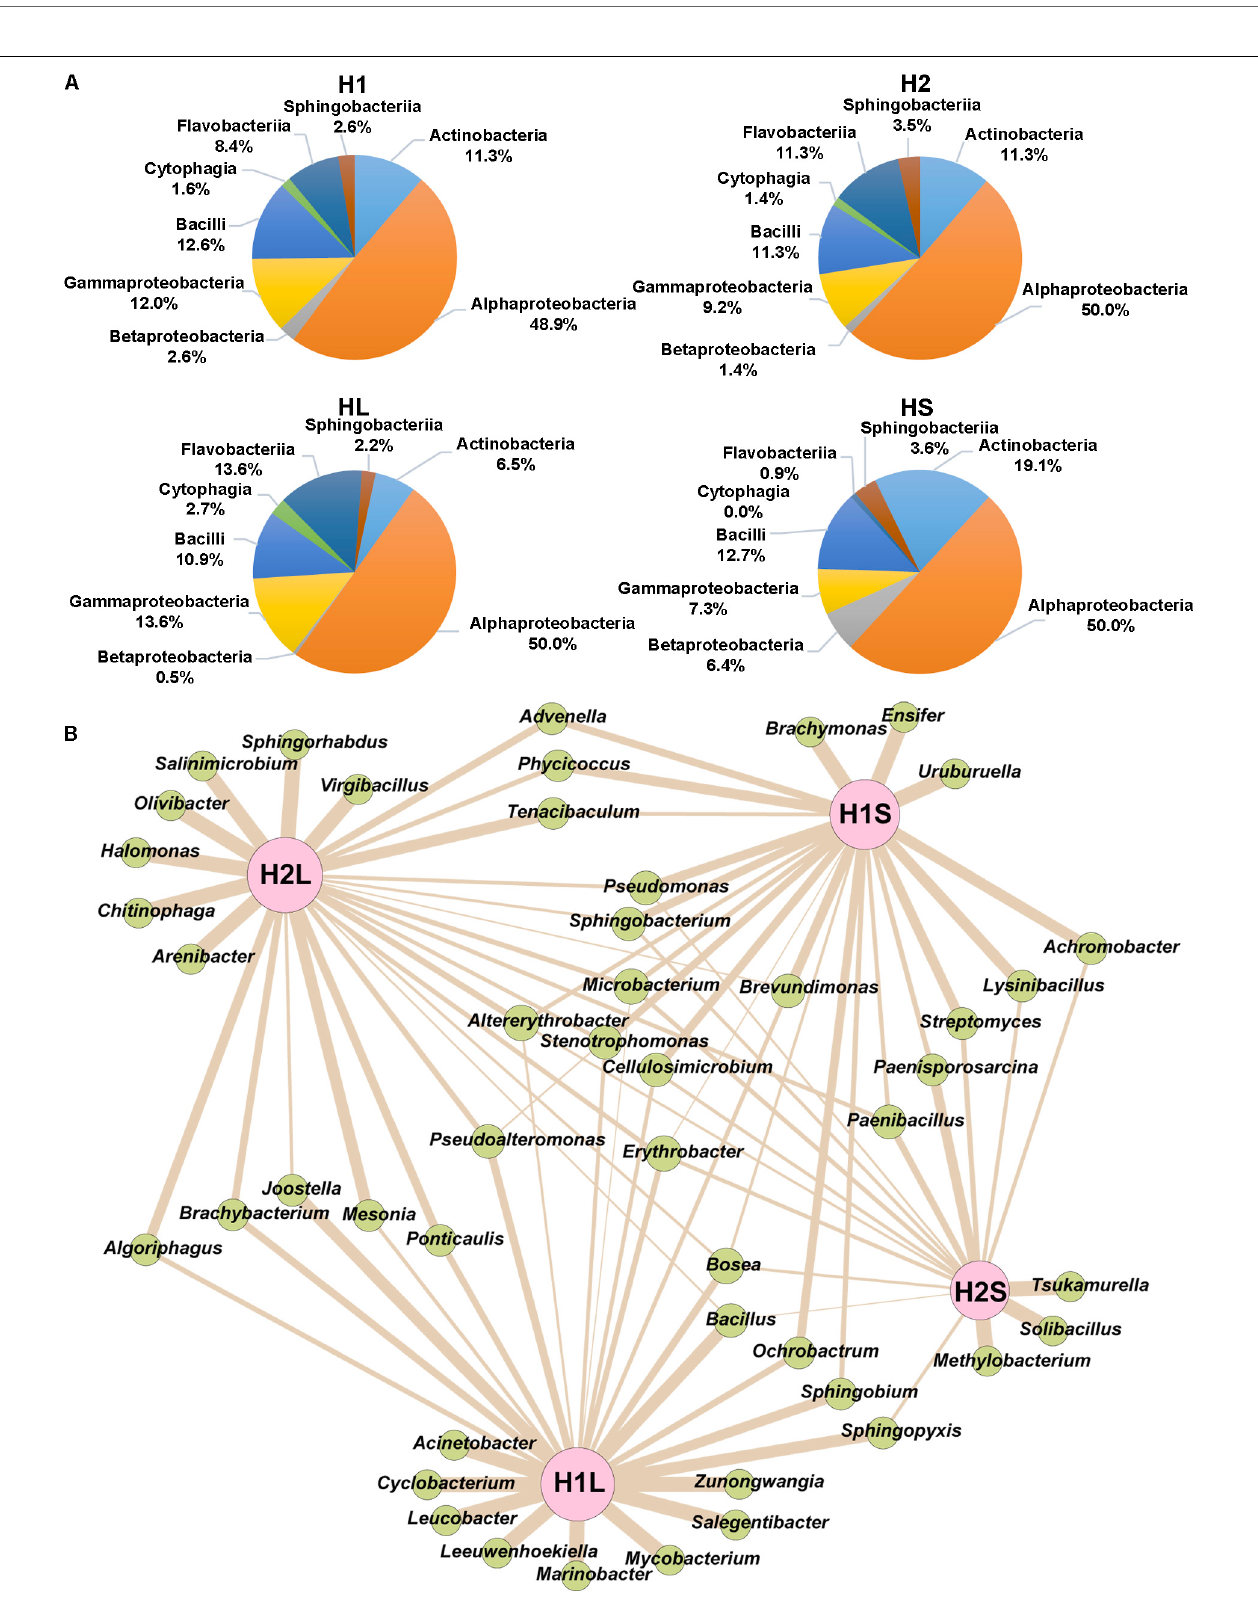
FIGURE 4 | Distribution of phylogenetically identified isolates by class and genus in the indicated samples. (A) Classes, (B) Genera; wideness of each connector bar of the network is proportional to the number of isolates in each genus.